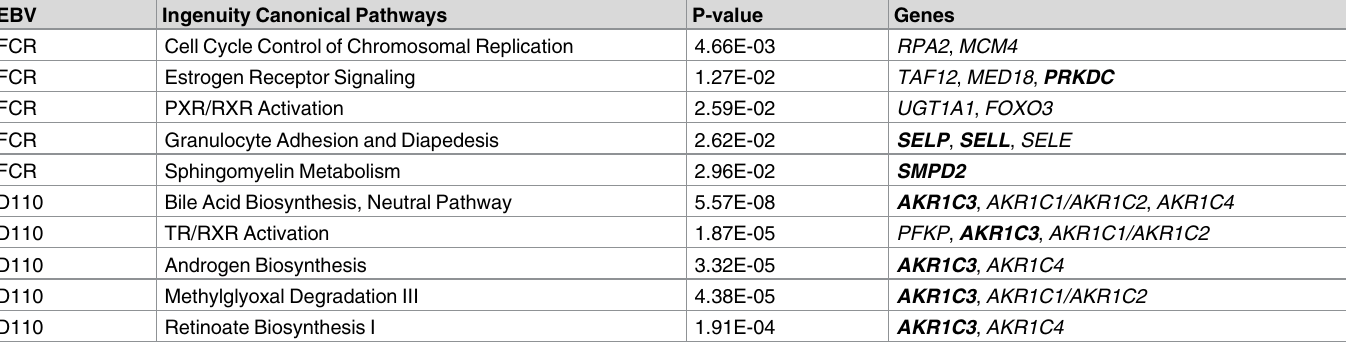
Table 4. Top canonical pathways for the positional and functional candidate genes located within 1Mb of the genome-wide significant markersfor EBV of FCR and D110.